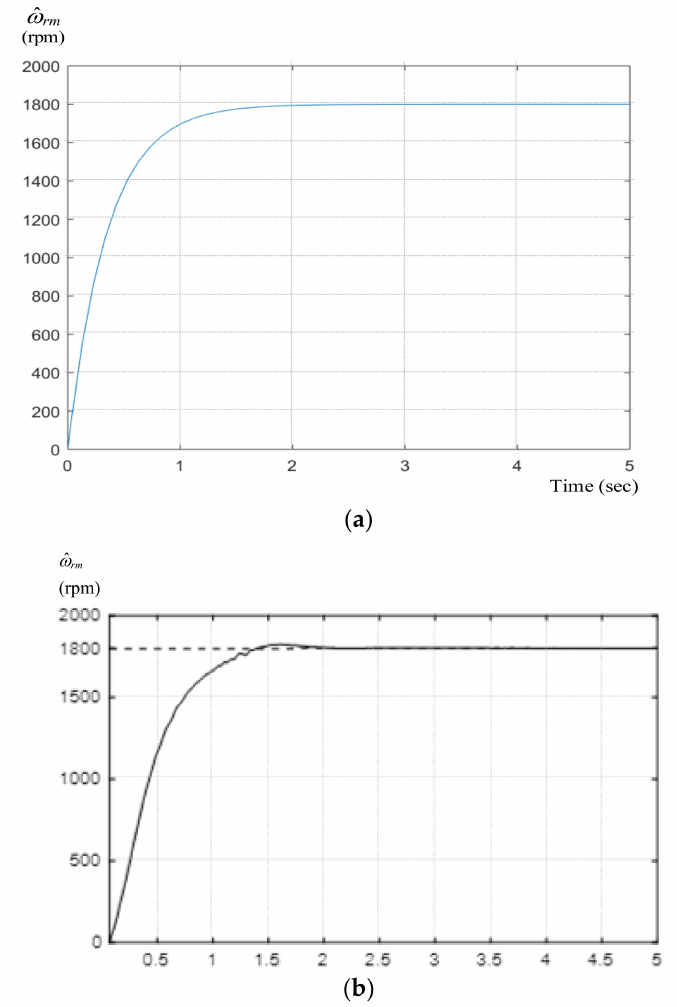
Figure 11. Highest step-input speed responses at 1800 rpm. ( a ) Simulated; ( b )